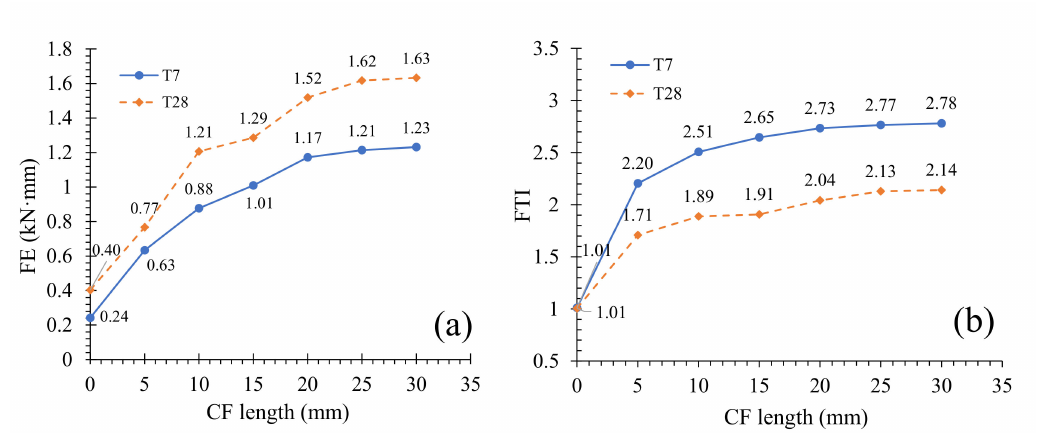
Figure 11. Flexural toughness: ( a ) flexural energy absorption (FE); ( b ) e ff ective flexural toughness